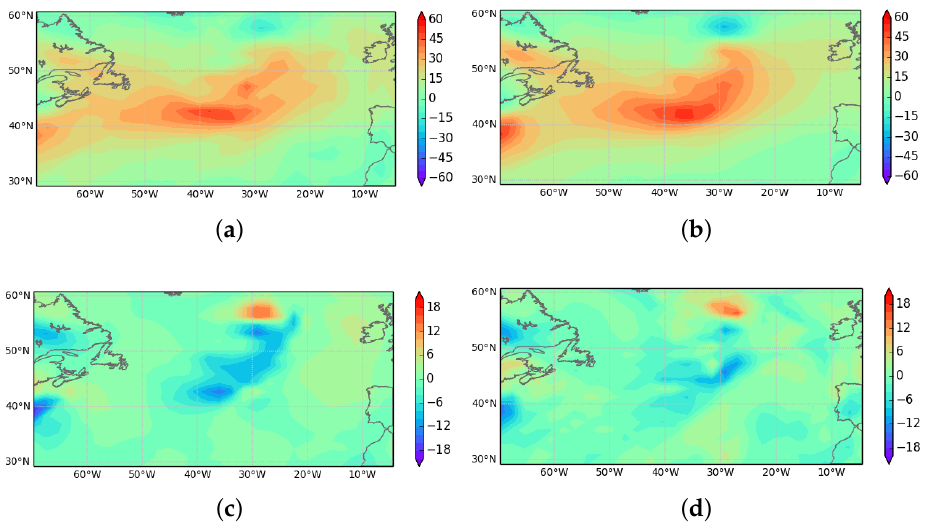
Figure 1. Zonal component of wind at 4000 m, units ms − 1 : ( a ) direct UM output; ( b ) geotriptic wind calculated from Equation (10); ( c ) ageotriptic wind from Equation (20); and ( d ) ageotriptic wind from UM